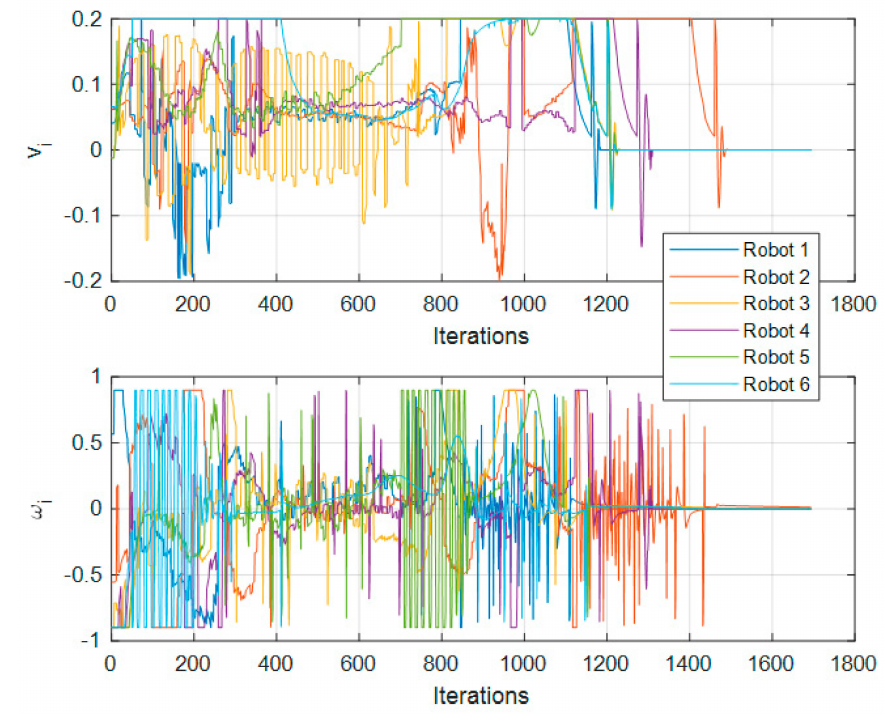
Figure 12. Input values for velocities along iterations in the 6-robot simulation. In respect of the 12-robot test, Figure 13 shows the trajectory followed by the robots in the simulation environment.